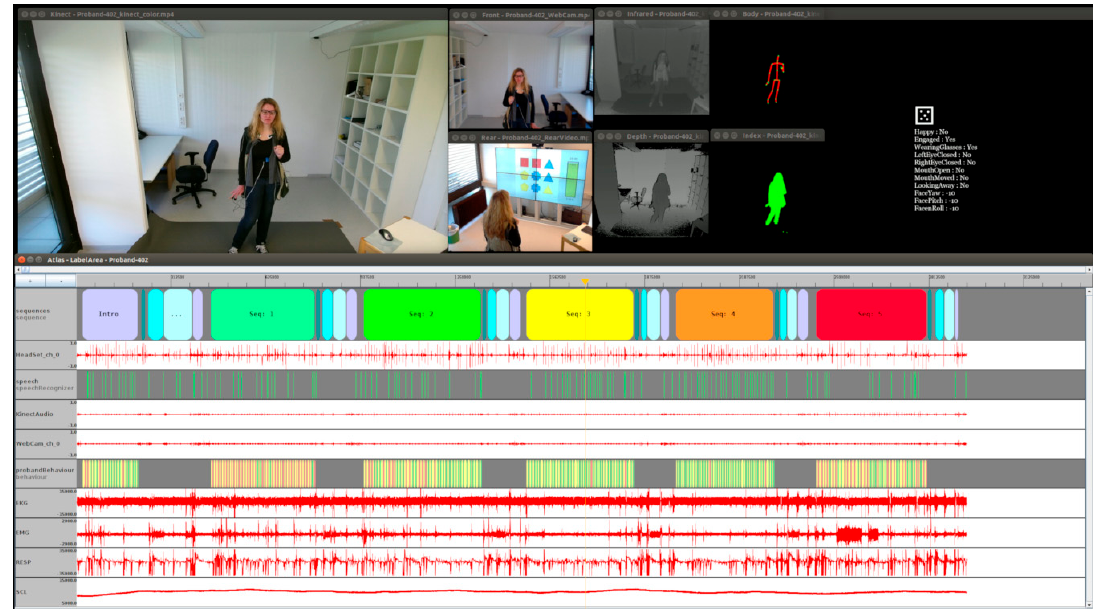
Figure 4. Overview of a whole recording session displayed in the multimodal annotation tool ATLAS: Kinect video ( top left ); Front webcam view, infrared and pose (first video row); rear camera, depth images (second video row); face position and simple facial estimations ( top right ). The data window contains from top to bottom: Sequence start and end information from logfile, audio, speech recognition information from logfile, stereo audio, front webcam, search, and answer phases including hit and miss from logfile, ECG, EMG, respiration, SCL.